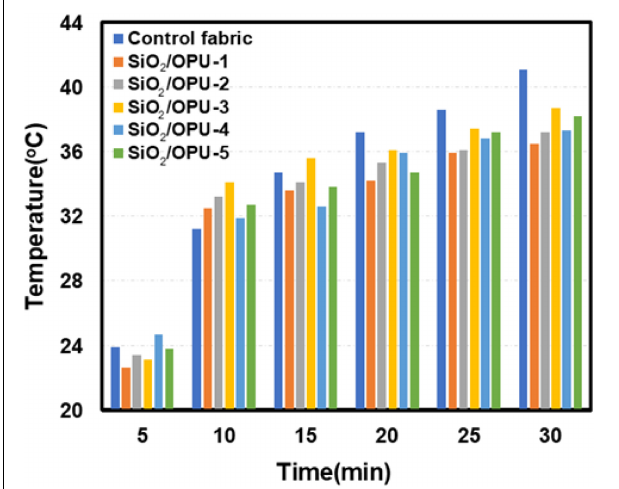
FIGURE 5 | Heat insulation performance of OPU/SiO 2